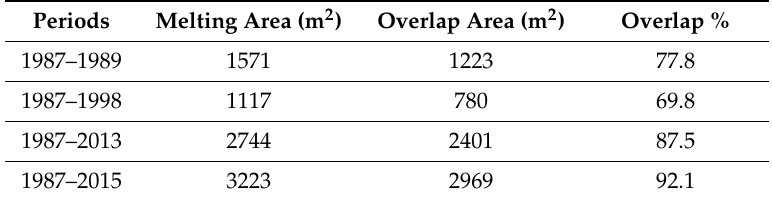
Figure 5. ( a ) Glacier boundaries in di ff erent years. ( b ) Map of glacier vulnerability classified by the melting area for di ff erent periods. Table 3. The percentages of overlap between the vulnerability map and the actual melting areas for di ff erent